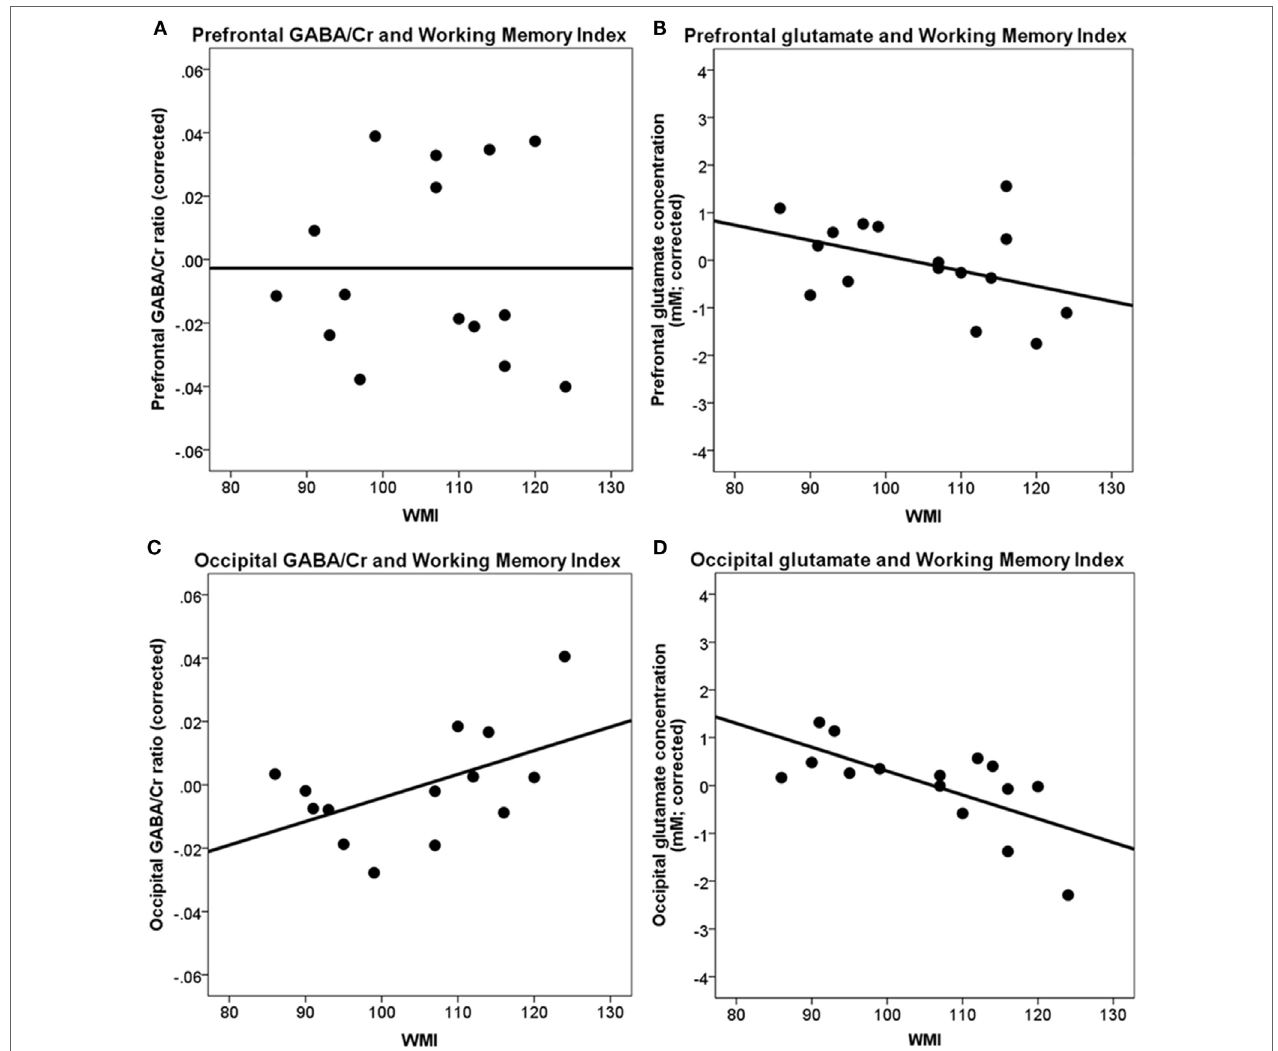
FigUre 4 | Correlations between prefrontal and occipital GABA/Cr and glutamate with working memory index (WMI). (a) Prefrontal GABA/Cr ratios are not significantly correlated with WMI; (B) prefrontal glutamate concentrations are not significantly correlated with WMI; (c) occipital GABA/Cr ratios are not significantly correlated with WMI; (D) occipital glutamate concentrations are significantly correlated with WMI [ r (10) = − 0.79, p < 0.004]. Data are presented corrected for gray and white matter fractions, age, and